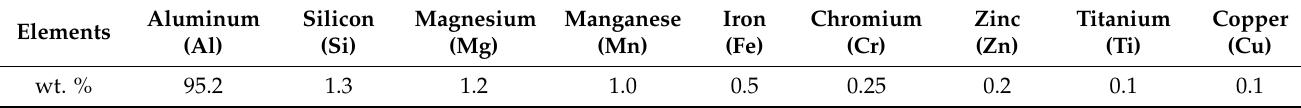
Table 1. Chemical composition of Al6082 alloy.